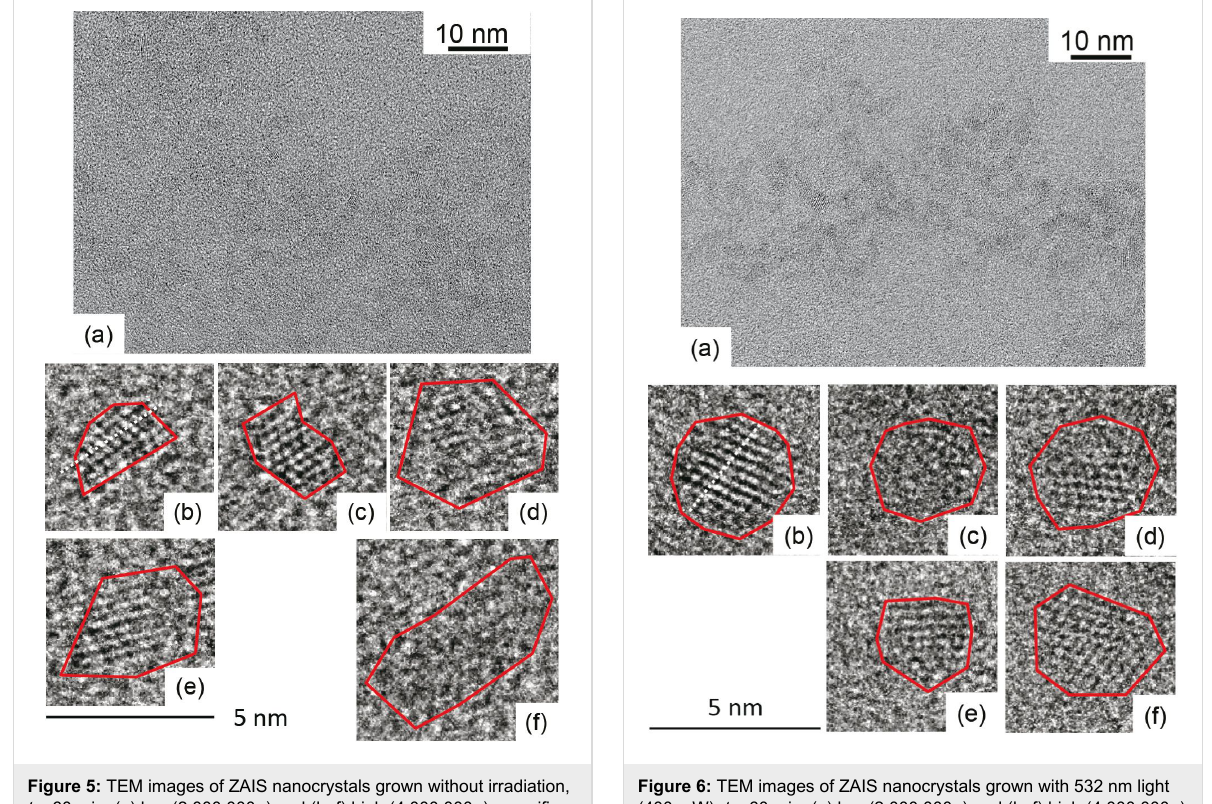
Figure 5: TEM images of ZAIS nanocrystals grown without irradiation, t = 60 min; (a) low (2,000,000×) and (b–f) high (4,000,000×) magnifica- tion.